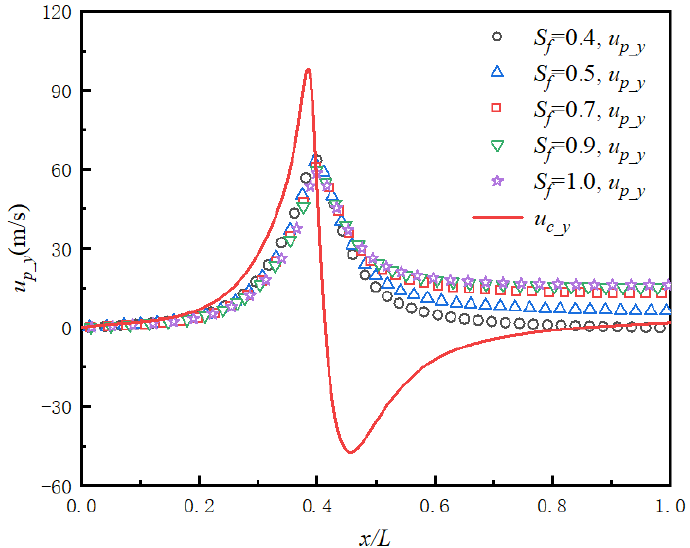
Figure 8. Velocity in the y -direction of the particle released from the same initial position with variable shape factors.